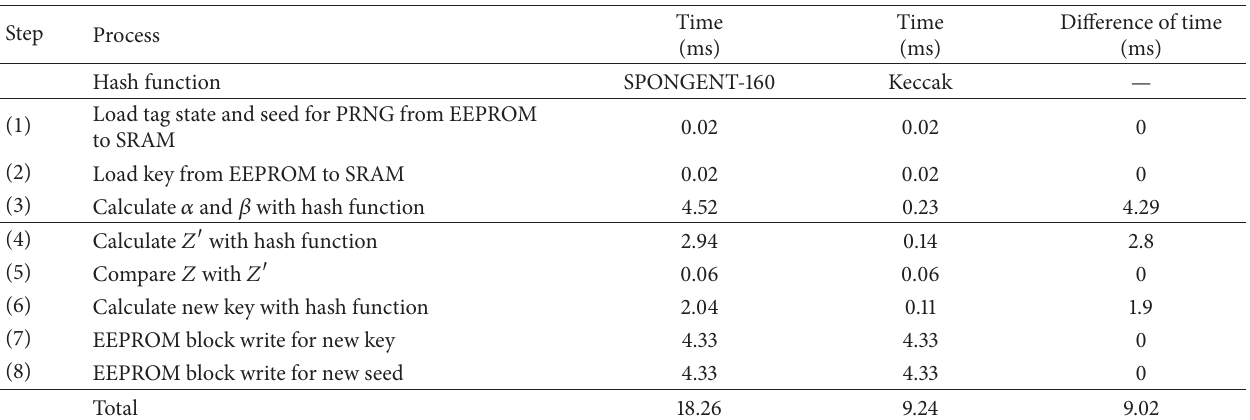
Table 3: Time evaluation of OMHSO protocol using SPONGENT-160 or Keccak on the tag. The results using SPONGENT-160 are already mentioned in [10].